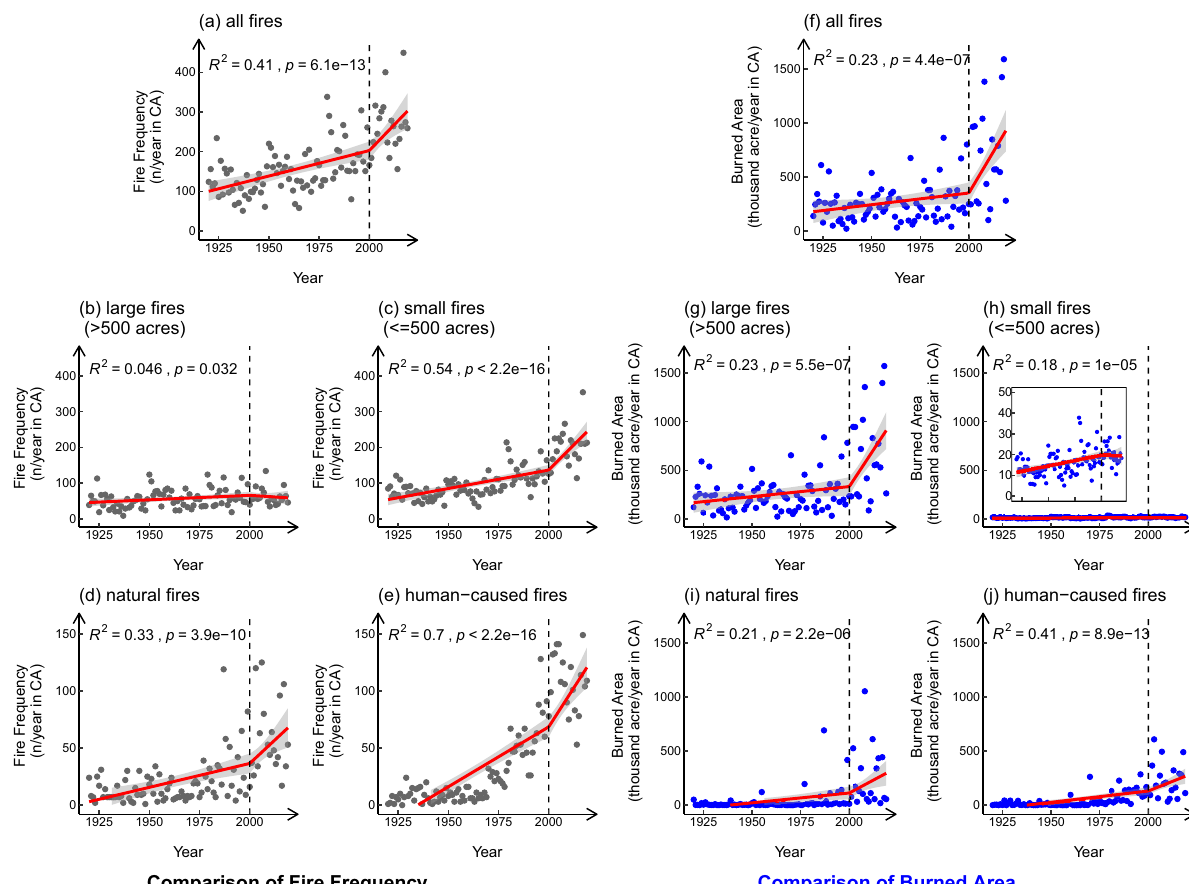
Figure 4. Temporal distribution of wildfire frequency and burned area from 1920 to 2019. The red line indicates the segmented linear regression results for 1920–1999 and 2000–2019. The gray areas indicate the 95 % 2 confidence interval. R represents the coefficient of determination and p represents the p-value. ( a – e ) are the temporal distribution of wildfire frequency, ( f – j ) are the temporal distribution of the burned area of wildfires; ( a , f ) are the distribution for all wildfires; ( b , g ) are plots of large fires, which have the burned area larger than 500 2 acres (2.02 km ), while ( c , h ) are plots of small fires, which have the burned area in the range of 10 acres (0.04 2 2 km ) to 500 acres (2.02 km ); ( d , i , e , j ) divided wildfires into natural fires and human-caused fires. The small plot in ( h ) zooms in to the burned area of 0–50 thousand